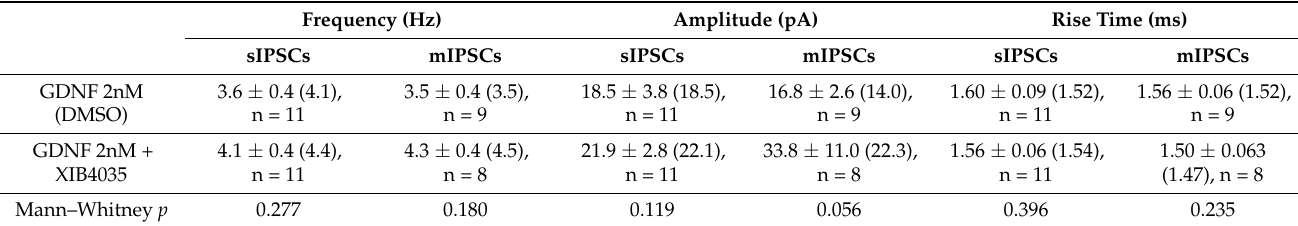
Table 2. Comparison of IPSC averages ± standard error of mean (and median) by cell following GDNF in 0.1% DMSO and GDNF/XIB4035 incubation for 1h. Frequency, amplitudes, and rise time values of IPSCs from slices incubated with GDNF only or GDNF and XIB4035 are shown along with